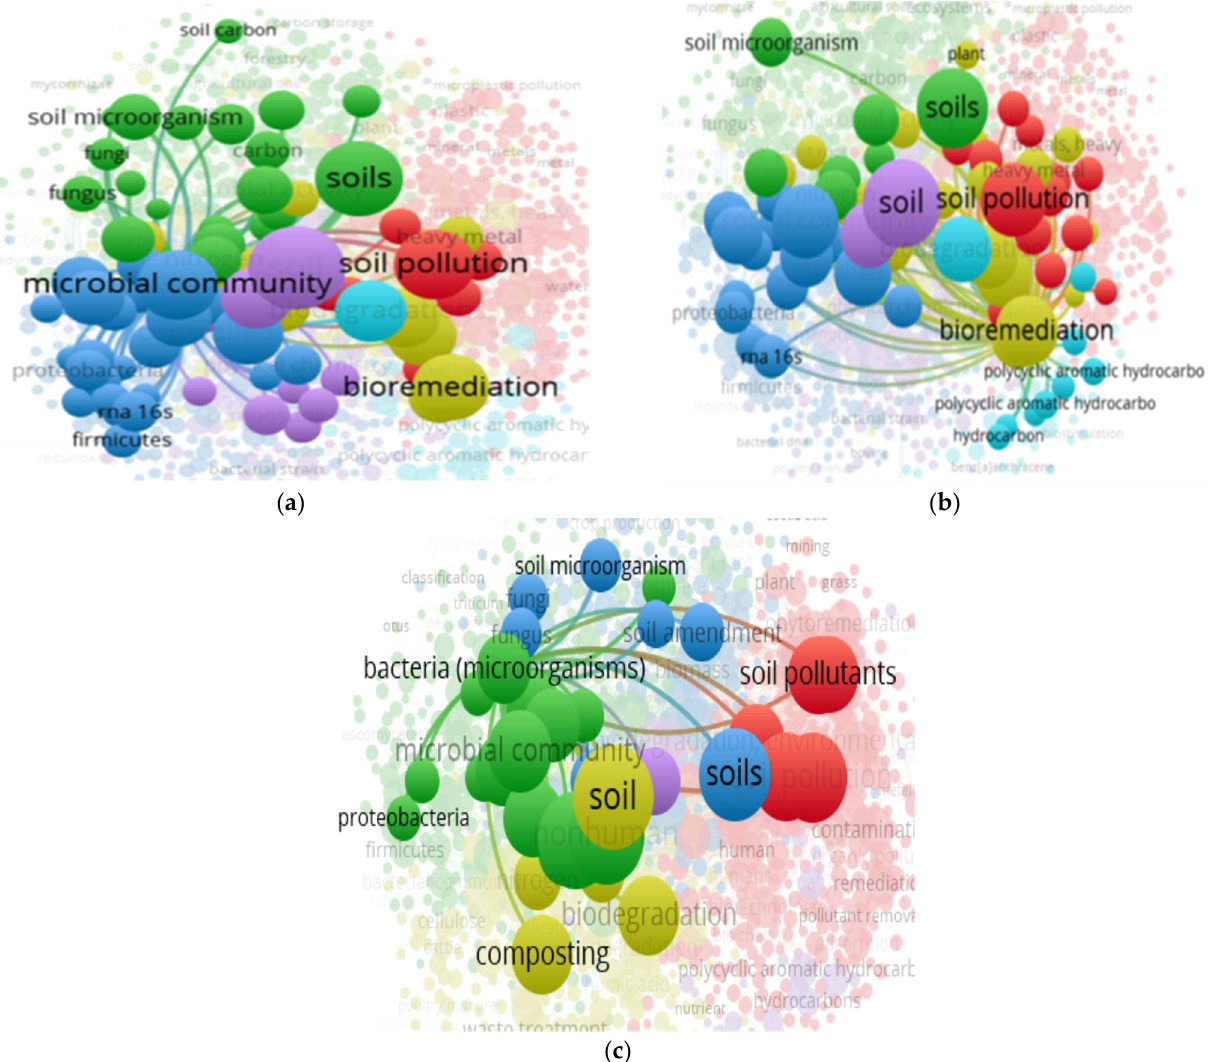
Figure 15. Analyzing Scopus results with the VOSviewer. Microbial community association with Proteobacteria; rna 16s ( a ) and soil pollution ( b ) and ( c ) soil association: bacteria; microbial community; proteobacteria (green circles).